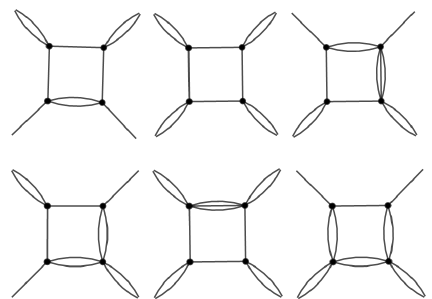
Figure 19: A few examples of trivial boxes. We have explicitly checked that the presented graphs do not admit an α -positive solution to the Landau equations.